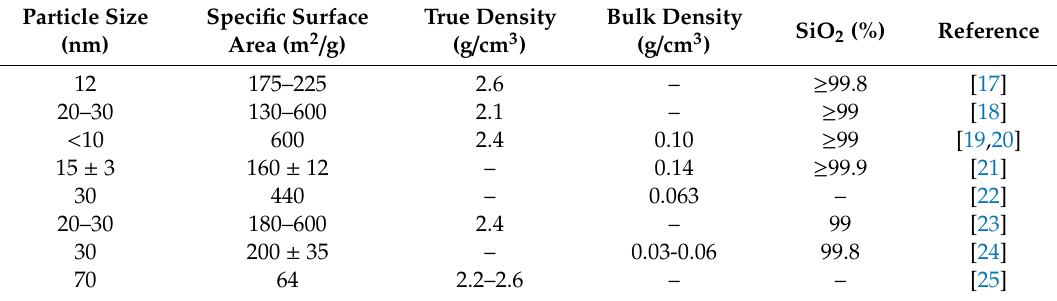
Figure 1. Mass of 2.50 g of limestone filler under 0.063 mm ( left ) and nanosilica ( right ). Table 1. Properties of nanosilica used by several authors.